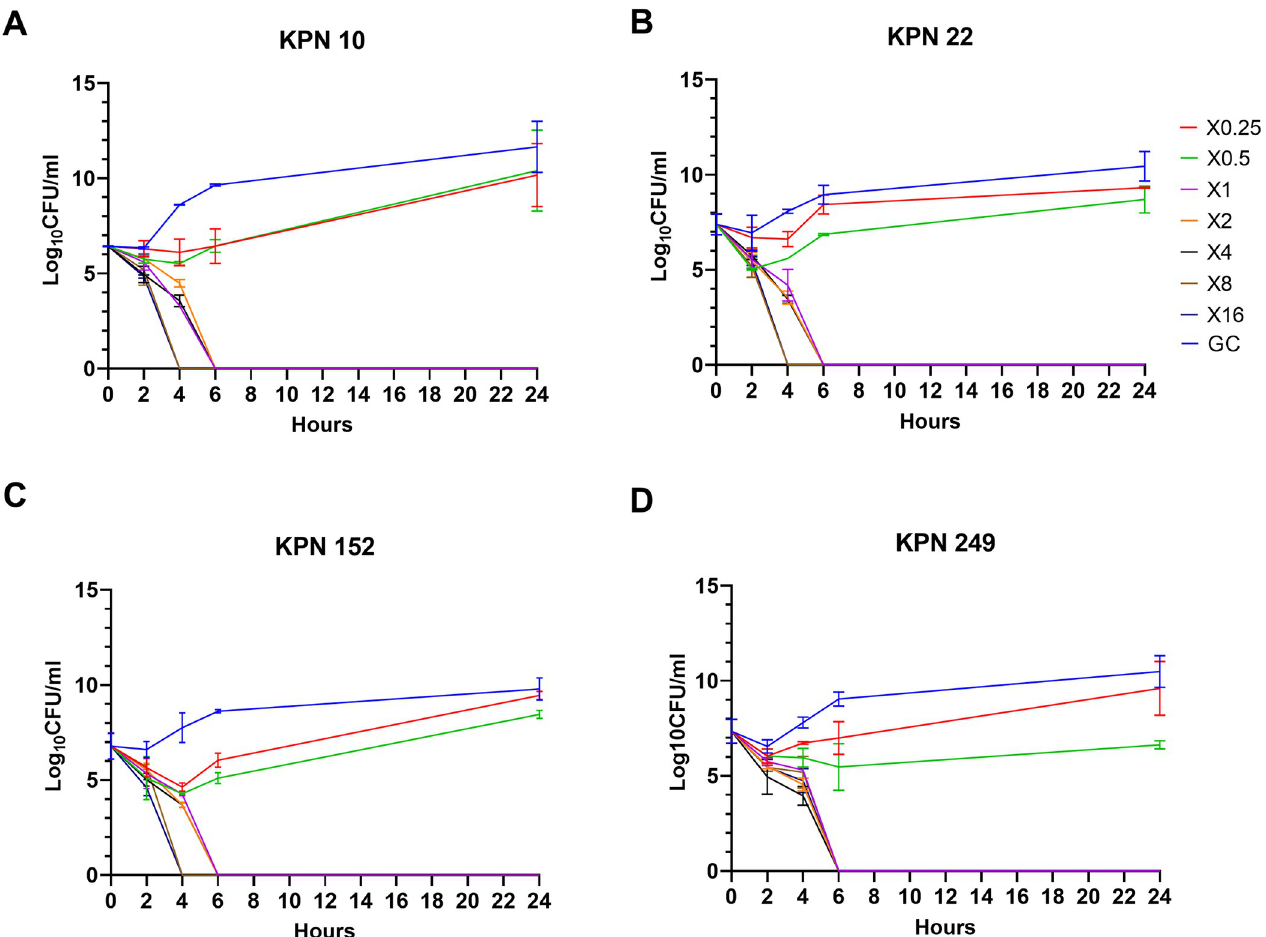
Fig 1. Representative time-kill graphs of four selected strains (A-D) treated with CFDC. Mean of duplicates from two independent experiments ± SD are shown. GC is untreated growth